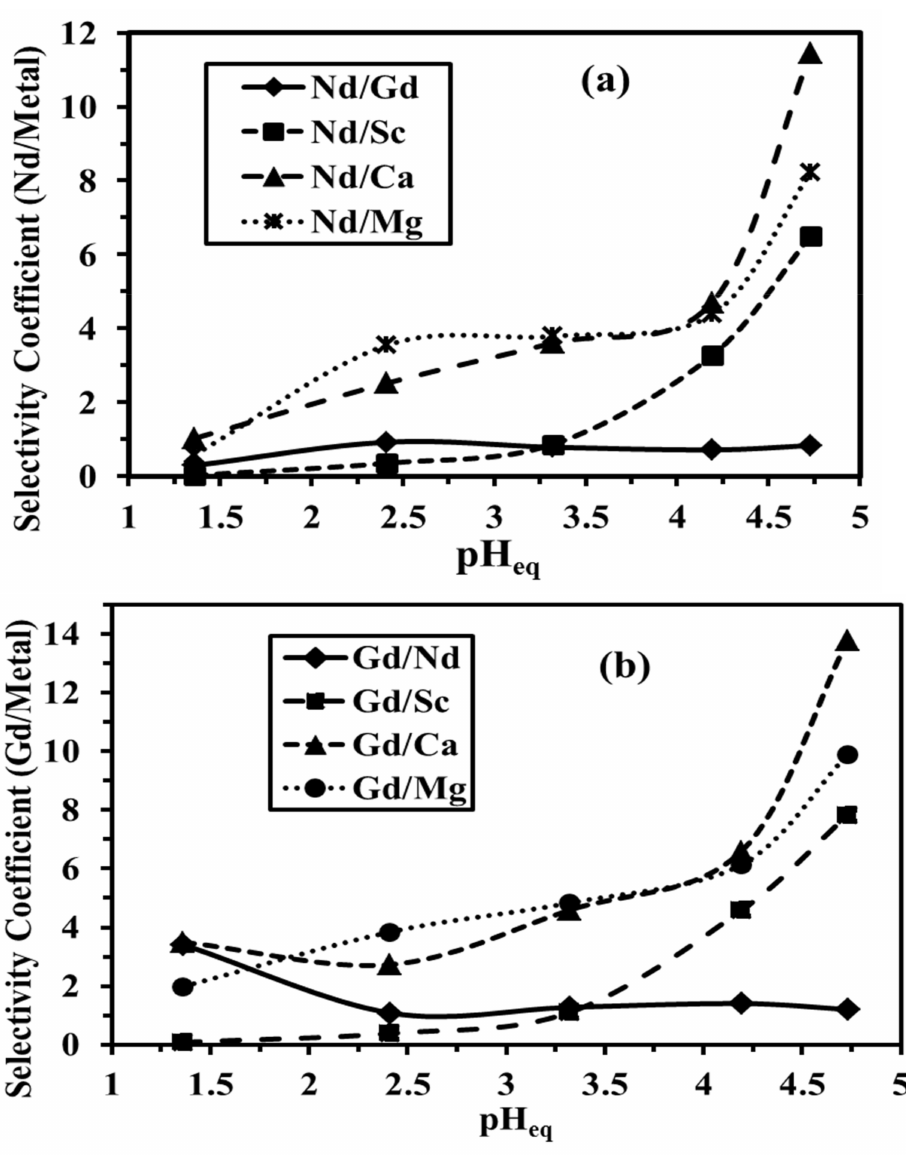
Figure 9. Sorption of Nd(III) and Gd(III) from multi-metal solutions—selectivity coefficient versus equilibrium pH (C 0 : 1 mmol metal L − 1 ; pH 0 : 1–5; pH eq : 1.36–4.73; SD: 0.125 g L − 1 ; agitation speed: 170 rpm; T: 22 ± 2 ◦